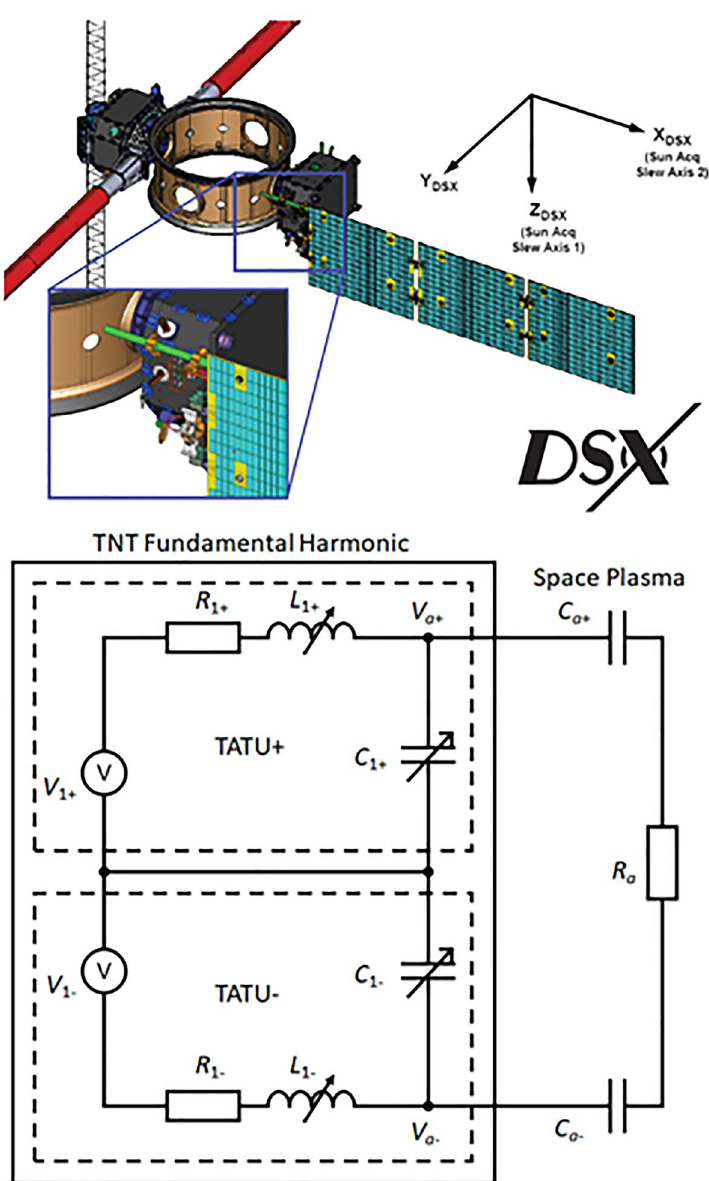
Figure 3. ( a ) The structure of DSX satellite, https:// direc tory. eopor tal. org/ web/ eopor tal/ satel lite- missi ons/ conte nt/-/ artic le/ dsx. The two branches of the TNT antenna are shown as the red cylinders, 40 m long each side separated by 2 m diameter satellite body. ( b ) Equivalent circuit of TNT presented in this